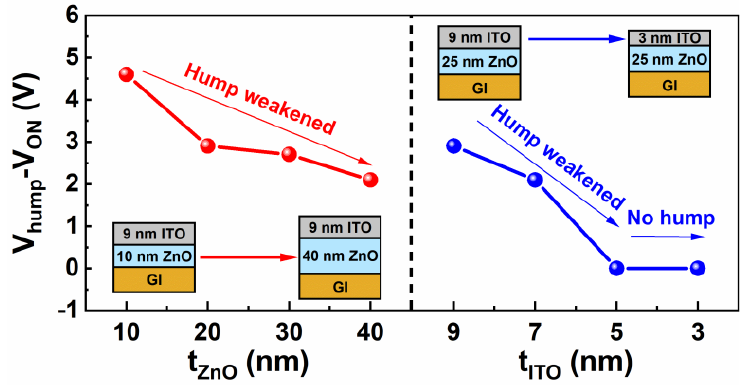
Figure 8. V hump – V ON versus t ZnO and t ITO . Figure 8. V hump –V ON versus t ZnO and t ITO .